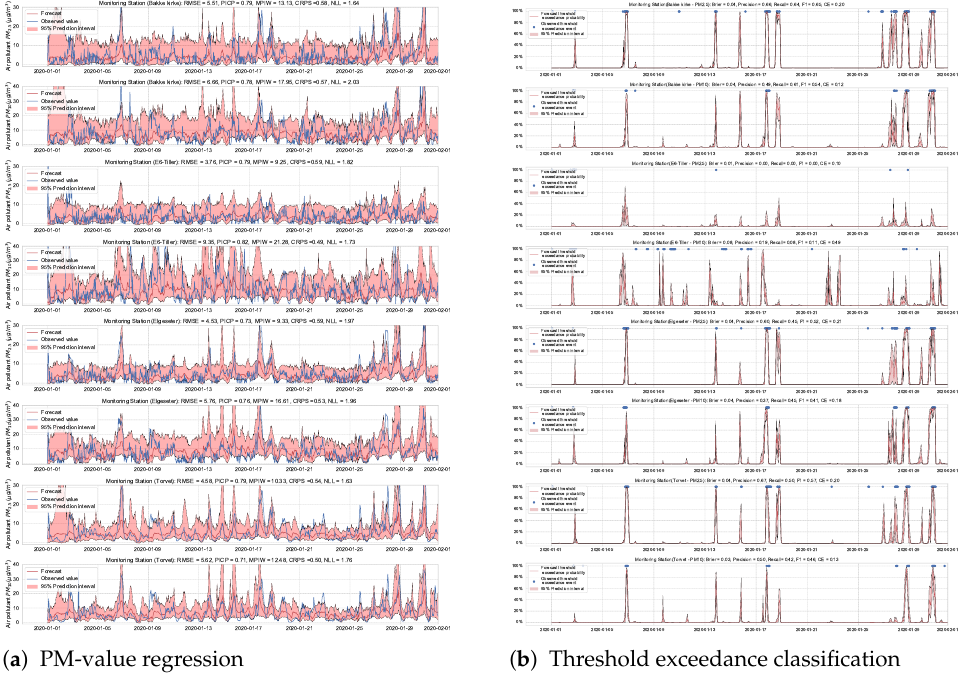
Figure A14. Deep probabilistic forecast of air quality using a SWAG model at four monitoring